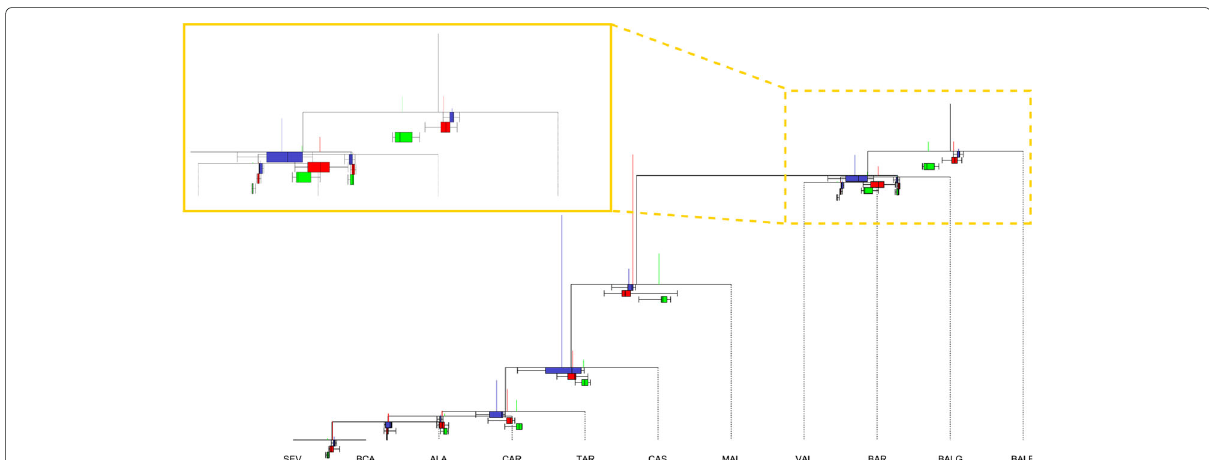
Fig. 10 Codadendrogram. SpanishMed balances of traffic composition following the selected SBP ((Table 5). Color: Blue corresponds to the period 1976–1989 (before containerization boom), red corresponds to the period 1990–2007 (before the crisis) and green corresponds to the period 2008–2015. The yellow box show a zoom of the BALG-BAR-VAL balances that is coherent with Fig. 6